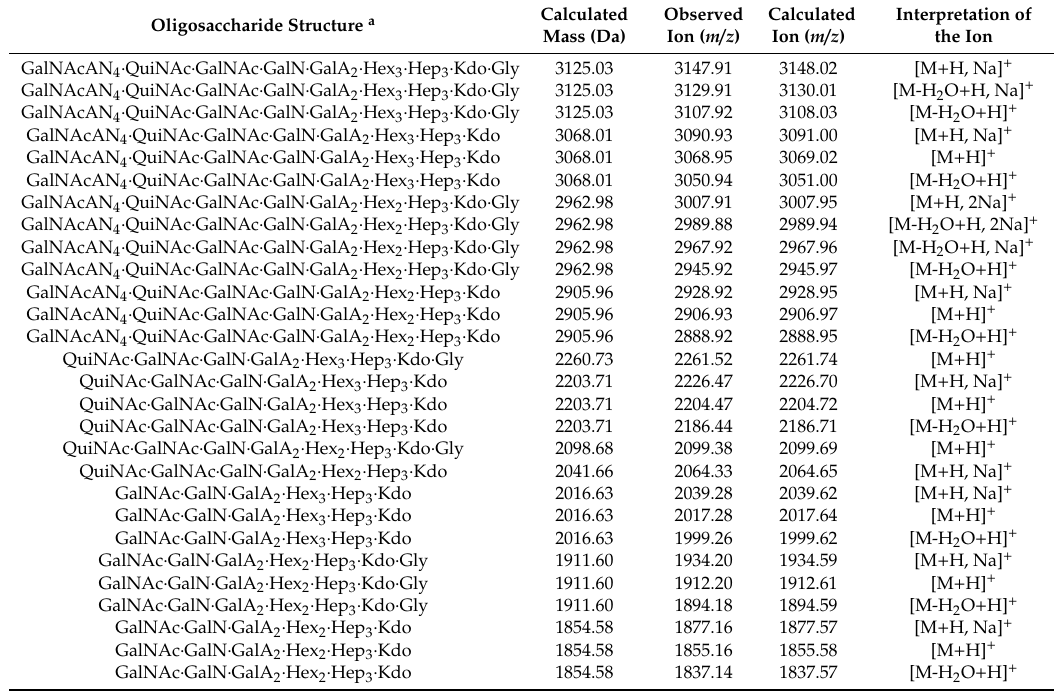
Table 2. Interpretation of positive ion mode MALDI-TOF mass spectra of the OS (Figure 3a) and the OSRU (Figure 3b) fractions isolated from LPS of P. shigelloides 90 / 89. Oligosaccharide Structure a